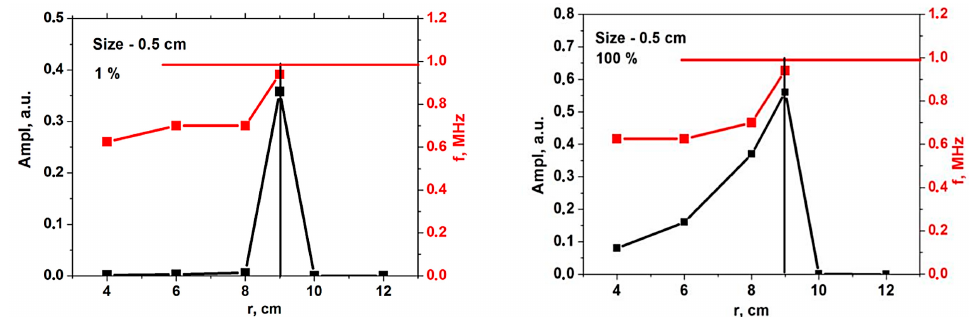
Figure 11. For the circular filament, the dependency of the signal amplitude (black line, scale on the left) and frequency (red line, scale on the right) on the radial position of the circular filament ( left ) with an amplitude of 1% of density at cutoff of the probing wave 48 GHz where the filament was positioned, and ( right ) a filament with an amplitude of 100%. The horizontal red line is the frequency predicted by the formula for the Doppler shift in the Born approximation.